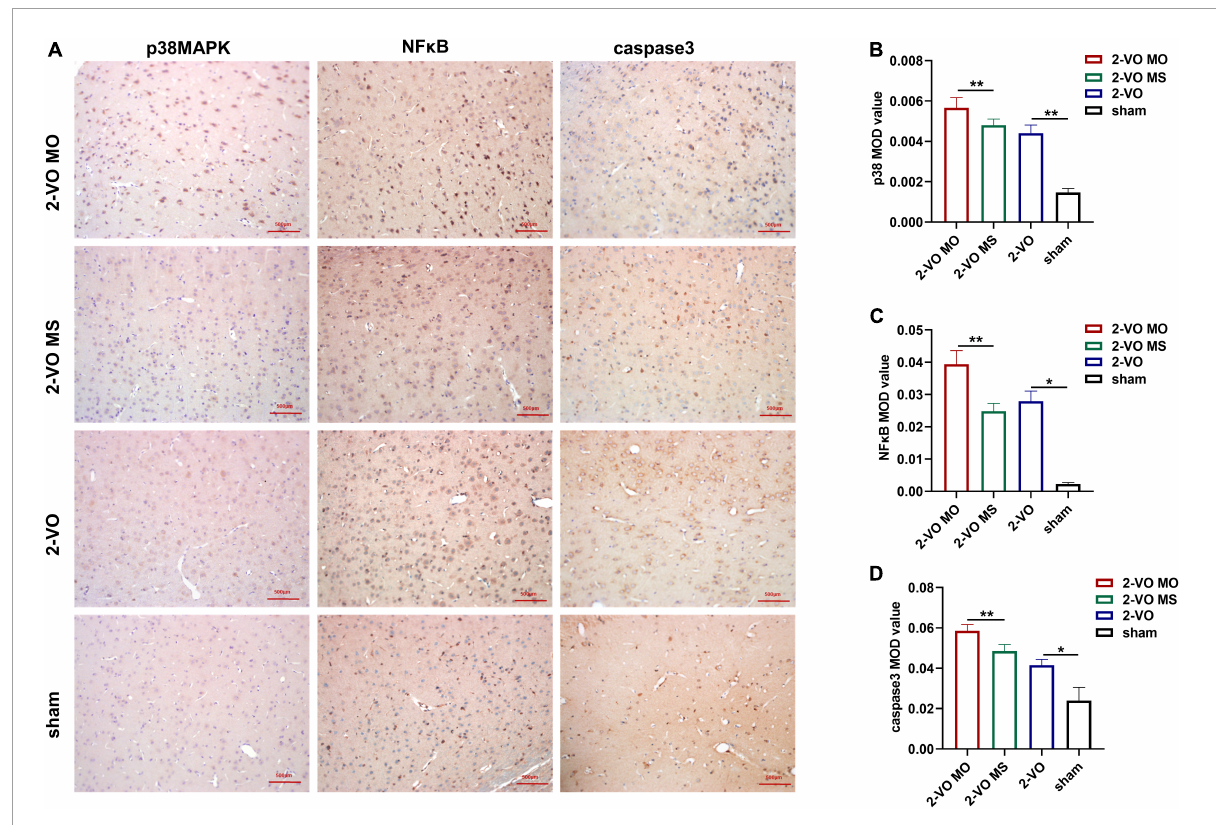
FIGURE6 Effects of molar loss on the protein expression of p38MAPK, NF κ B and caspase3 in the CA1 region of rat hippocampus. (A) Representative IHC images of p38MAPK, NF κ B, and caspase 3 (IHC, × 200). (B–D) The MOD values are expressed as mean ± SD, n = 4, * p < 0.05, ** p <